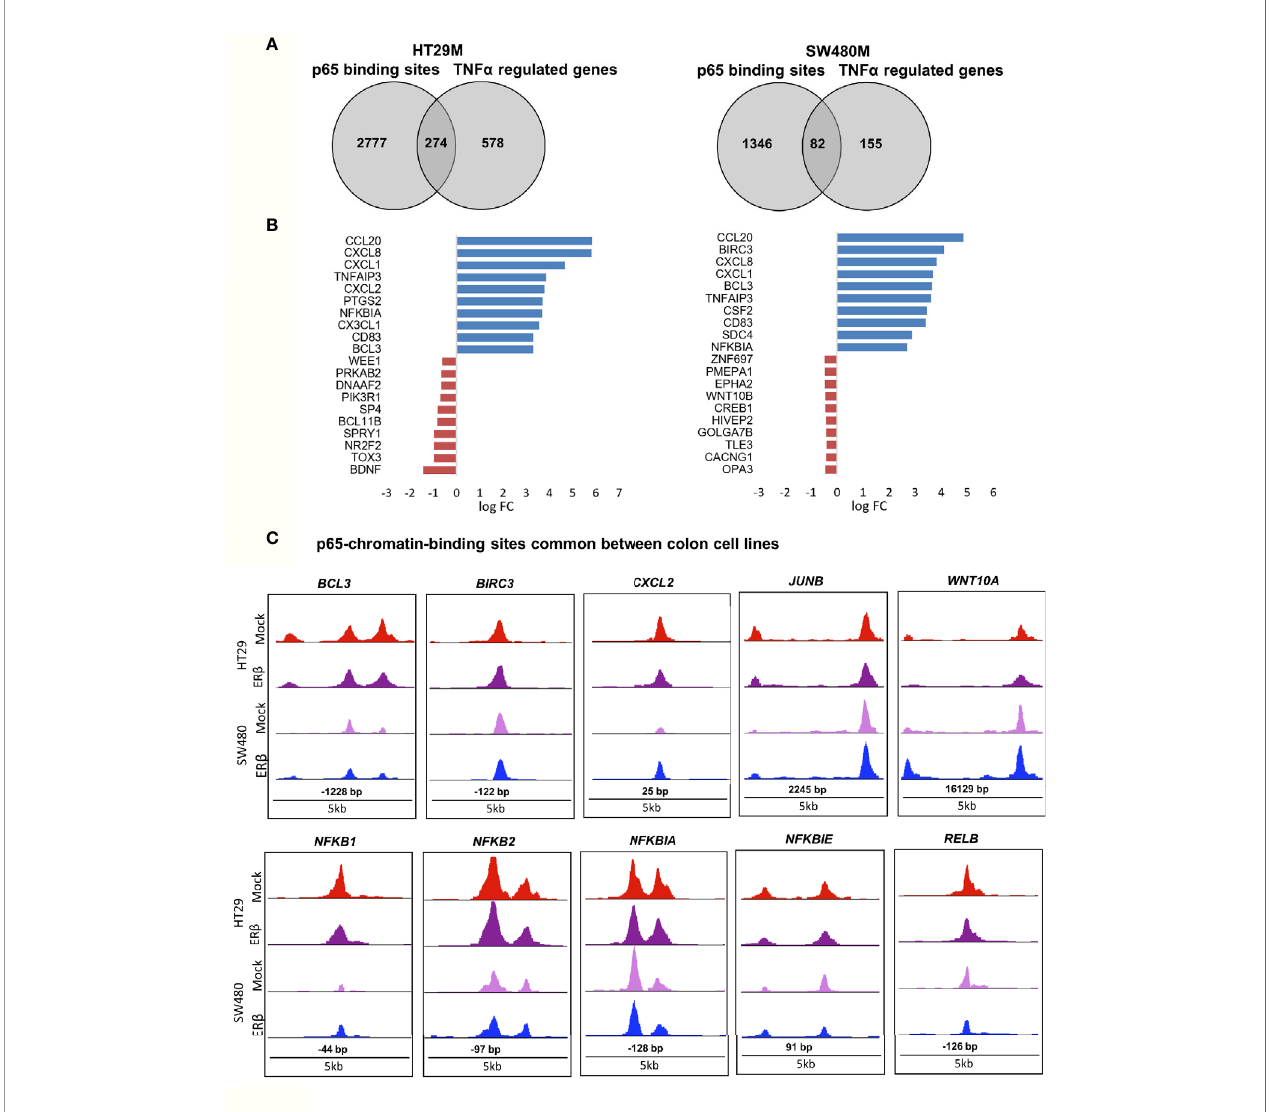
FIGURE 3 | p65 transcriptional regulation in colon cell lines. (A) Number of genes with p65 chromatin binding sites and corresponding transcriptional regulation upon TNF a (10ng/ml, 2 h) treatment, per cell line. (B) The top-10 TNF a upregulated and downregulated genes with p65 binding sites in both cell lines (HT29, SW480). (C) Enrichment signal of p65 binding sites present in both cell lines, illustrated using UCSC genome